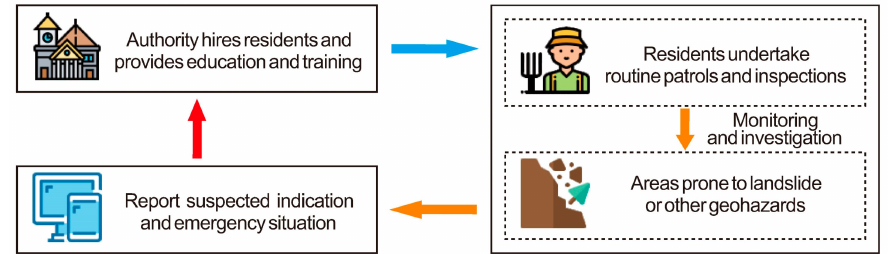
Figure 9. The framework of the community-based monitoring in the Three Gorges Reservoir (TGR)